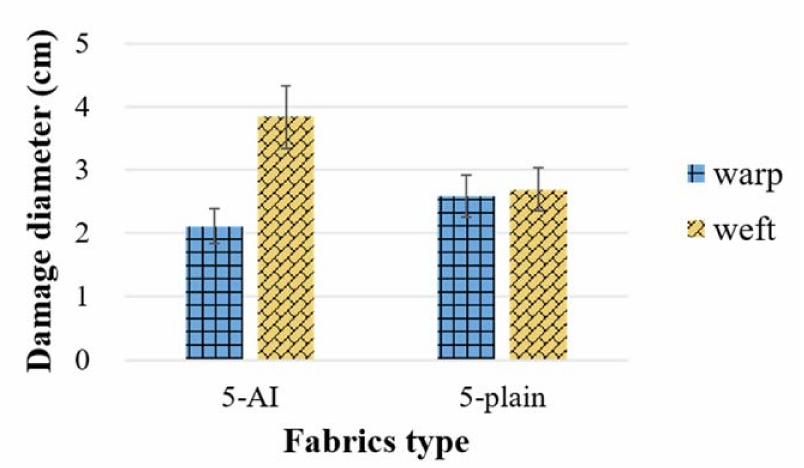
Figure 9. Damage size of fabric panels at the back face. Figure 10 outlined the displacement of 5-AI and 5-plain panels at their failure moment.